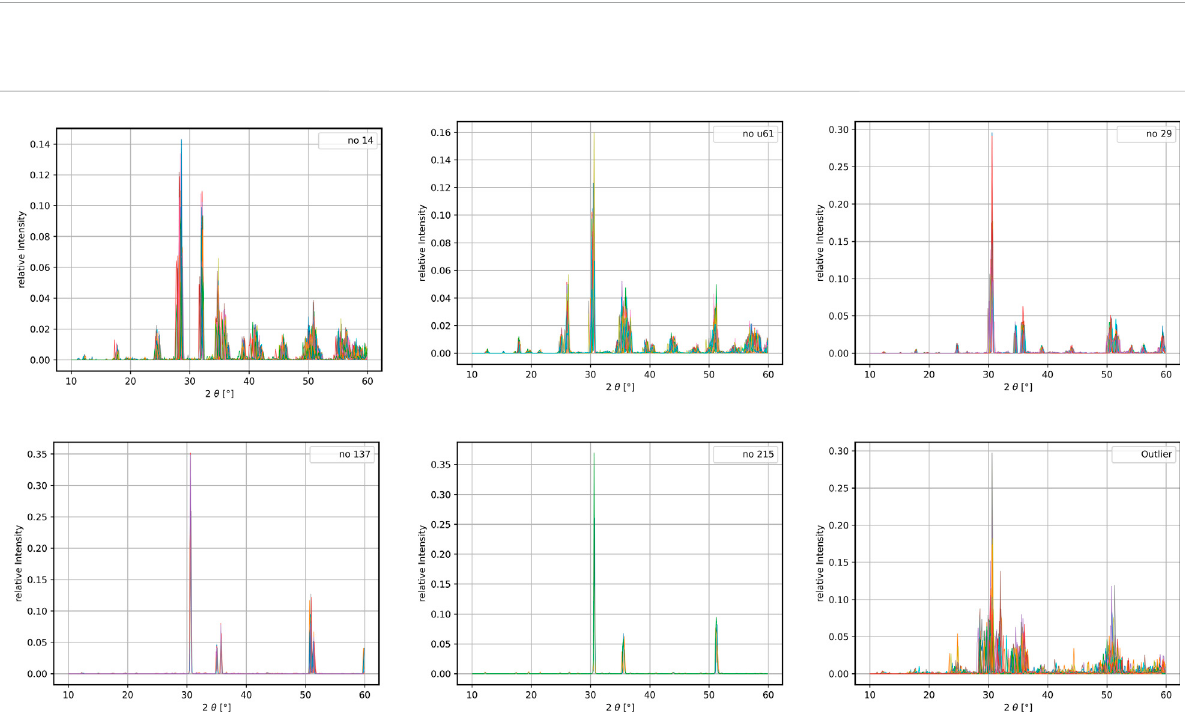
FIGURE 7 Displayed are the XRD-spectra of the initial ZrO 2 -structures, the emerged cluster no 215 and the highly heterogeneous outlier cluster. A closer investigationoftheno 215 cluster reveals that 6.25% doping withGallium,Germanium, Aluminum andChromium leads to thetransitionfrom theno 137 to the no